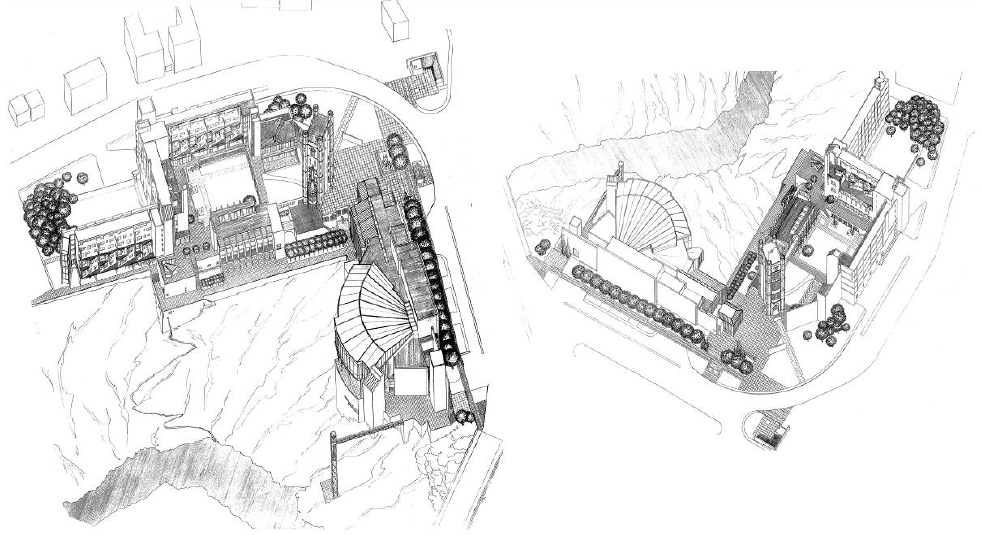
Figure 1. The first Full Calendar Year Cornell BArch thesis in a decade, the design for a Residential College/performing arts center that included Ruins of a "College Gothic" building and multiple "styles" to create spaces and forms, distinct from the International Modernism tradition of Cornell architectural school.